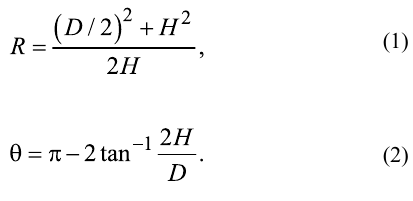
In the figure, γ SL (72 mN/m for water), γ SV , and γ LV are the surface tensions at the solid–liquid, solid–vapor, and liquid–vapor interfaces, respectively. H , D , R , and θ are the NB height, diameter, radius of curvature, and contact angle, respect- ively. H and D can be directly obtained from the selected cross section. By assuming the cross section is an elliptical arc, R and θ are given as: